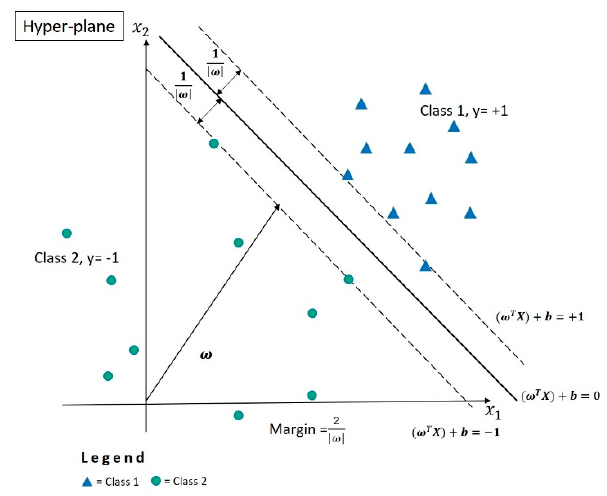
Figure 4. The most significant margin for the optimal linear classifier (hyperplane), modified from Deng et al. [50].